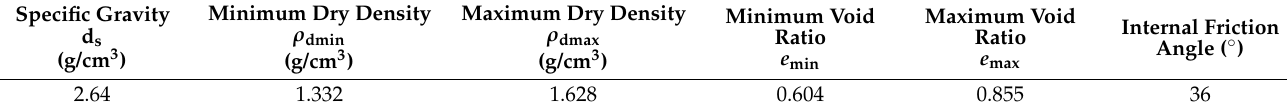
Table 3. Physical parameters of Fujian standard sand.